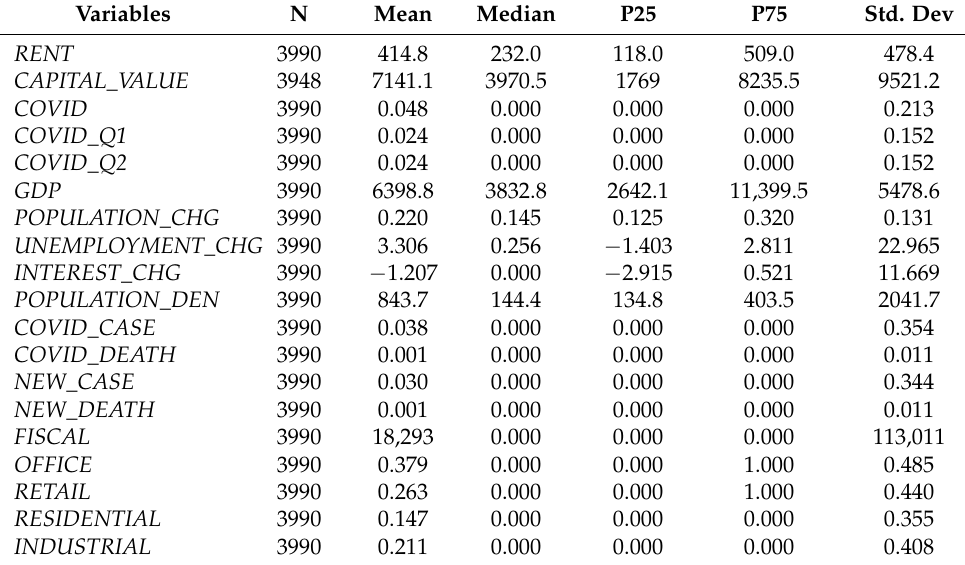
Table 2. Descriptive Statistics. This table provides descriptive statistics for the sample observations of the variables used in the empirical tests. Variable definitions are provided in Appendix